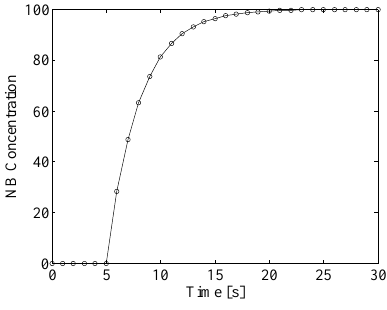
Figure 2: Transmission delay of nanoparticle con- centration within the compartment model, versus different values of the dissolution constant. Higher the dissolution constant, lower the nanoparticle transmission delay.